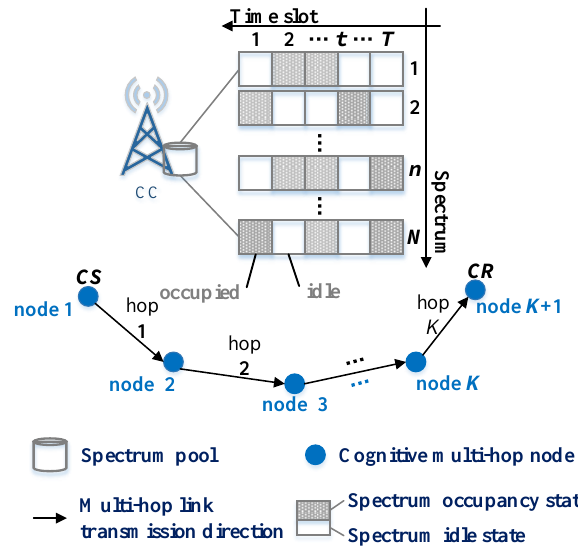
Figure 2. System description of the cognitive multi-hop multi-channel transmission